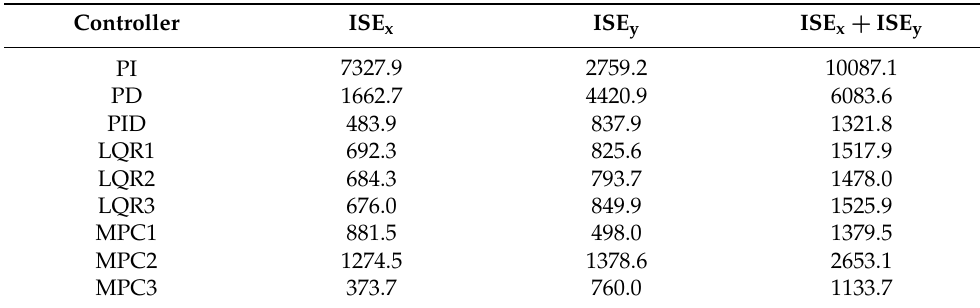
Table 3. Control errors for all compared control algorithms (ISE x : the error for the X axis, ISE y : the error for the Y axis).